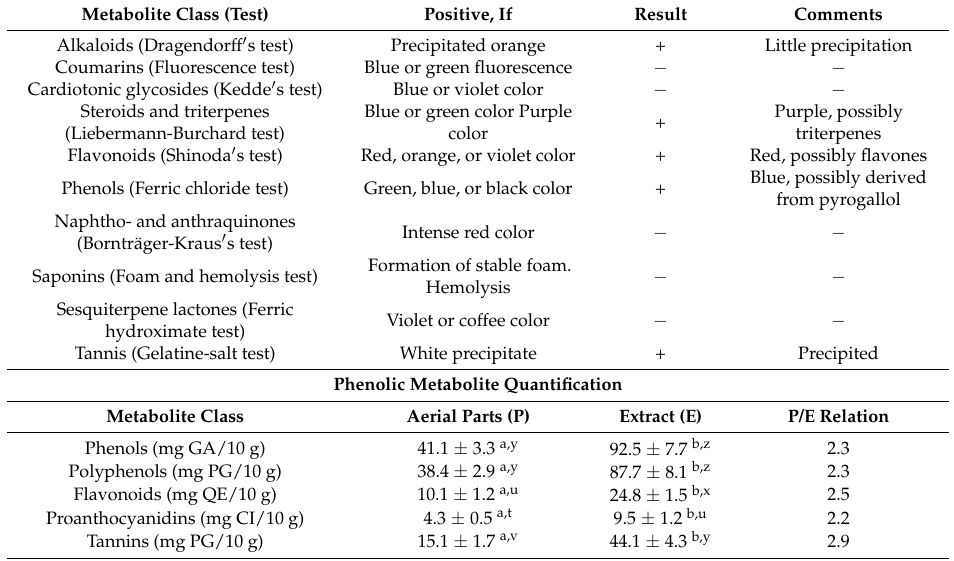
Table 1. Berberis goudotii preliminary phytochemical analysis and phenolic metabolite